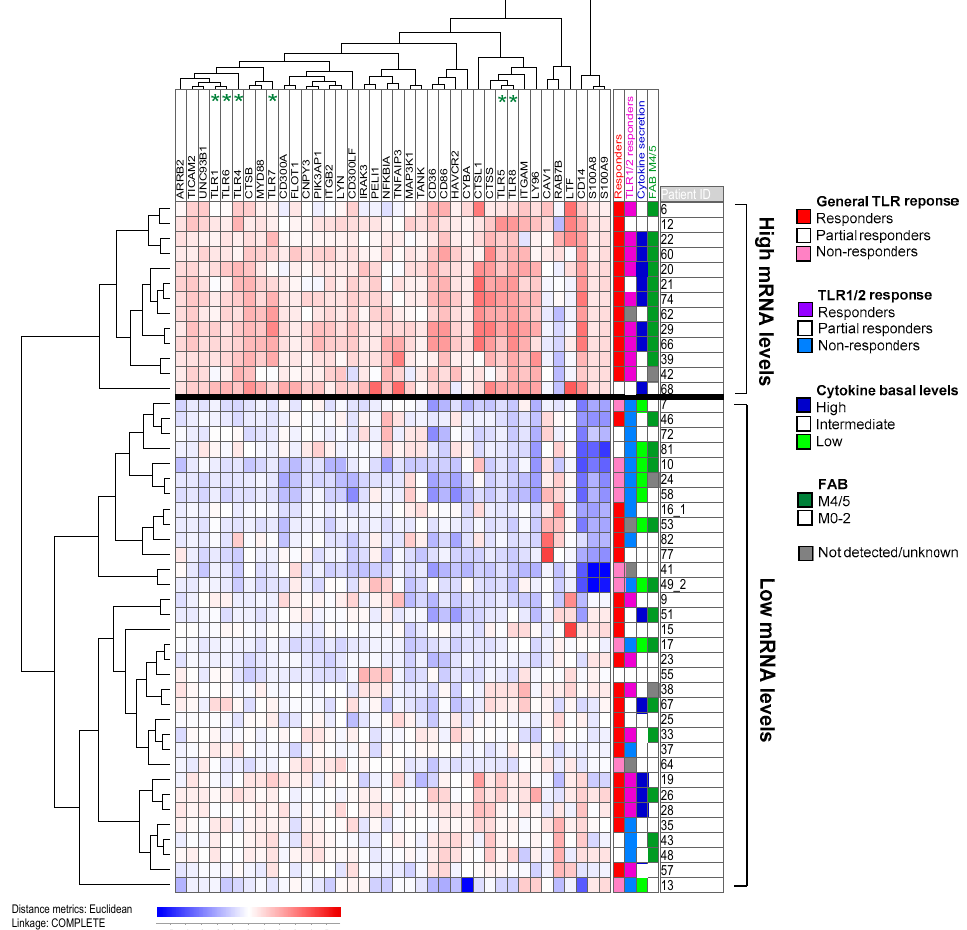
Figure 3. A cluster containing the 38 out of 129 genes belonging to the GO-term “TLR signaling” (based on the AmiGO database) that were most differentially expressed among the 46 unselected patients in our study. The remaining genes, including TLR2, showed only minor variations among patients and did not differ significantly between the two identified clusters. Six of the ten TLR receptors showed differential expression (i.e., were included among the 38 genes) and are indicated at the top of the figure. All values were median normalized and log 2 -transformed, thus red and blue color indicate values above and below the median, respectively. The most differentially expressed genes were the TLR4 co-receptor CD14, and the TLR4 ligands S100A8 and A9 (on the far right). Patient distribution in the cluster was correlated with response upon TLR induction, especially by the TLR1/2 ligand Pam3CSK4, basal cytokine secretion levels and monocytic cell differentiation according to the FAB system. The numbers behind the patient ID correspond to the de novo sample (1) and the relapse sample (2) for patients with cells sampled at dual time points. All cells included in this analysis were gradient-separated and cryopreserved primary AML cell as described in Section 4.1. mRNA was prepared immediately after thawing without any kind of cell stimulation/incubation.